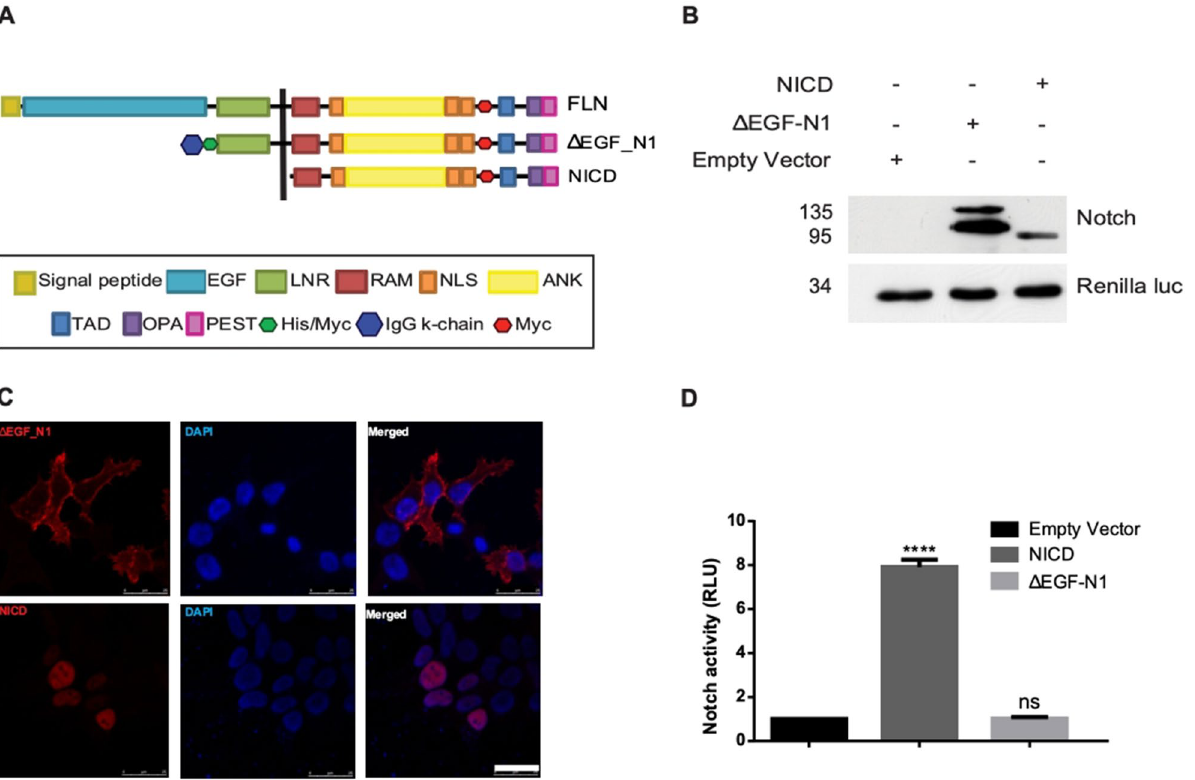
Figure 1. Characterization of ΔEGF_N1 and NICD constructs. ( A ) Schematic showing the structure of the full length, ΔEGF_N1 and NICD proteins. ( B ) Western blot analysis of ΔEGF_N1, NICD constructs and empty vector. Expressed proteins were detected by probing the western blot with an antibody that recognises the myc epitope tag found within both proteins. Renilla luciferase is shown as a loading control. The position of molecular weight markers is shown in KDa. ( C ) Immunofluorescence analysis of ΔEGF_N1 and NICD proteins. Scale bar is 25 μm. ( D ) Unlike NICD, ΔEGF_N1 failed to activate Notch signalling. HEK293T cells were transfected with p10xRbpj-luc either alone or with plasmids encoding the ΔEGF_N1 and NICD proteins. Experiments were performed in triplicate. pRL-CMV was used as a transfection control and cells were lysed 48 h post transfection to determine luciferase activity. Data are presented as mean fold change (± SEM) in RLU (NS P > 0.05; **** P < 0.0001 one-way ANOVA and Tukey’s post-hoc test, N = 3). Original uncropped Western Blot images of panel B are shown in Supplementary Fig.